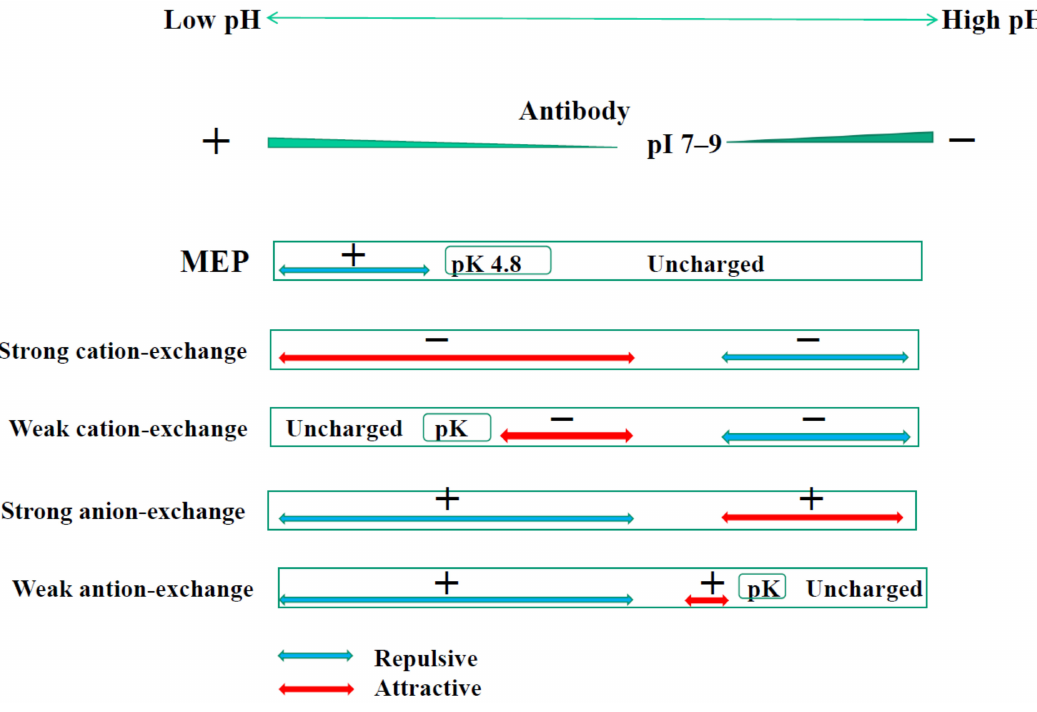
Figure 4. Charged states of several mixed-mode resins and antibodies as a function of pH.